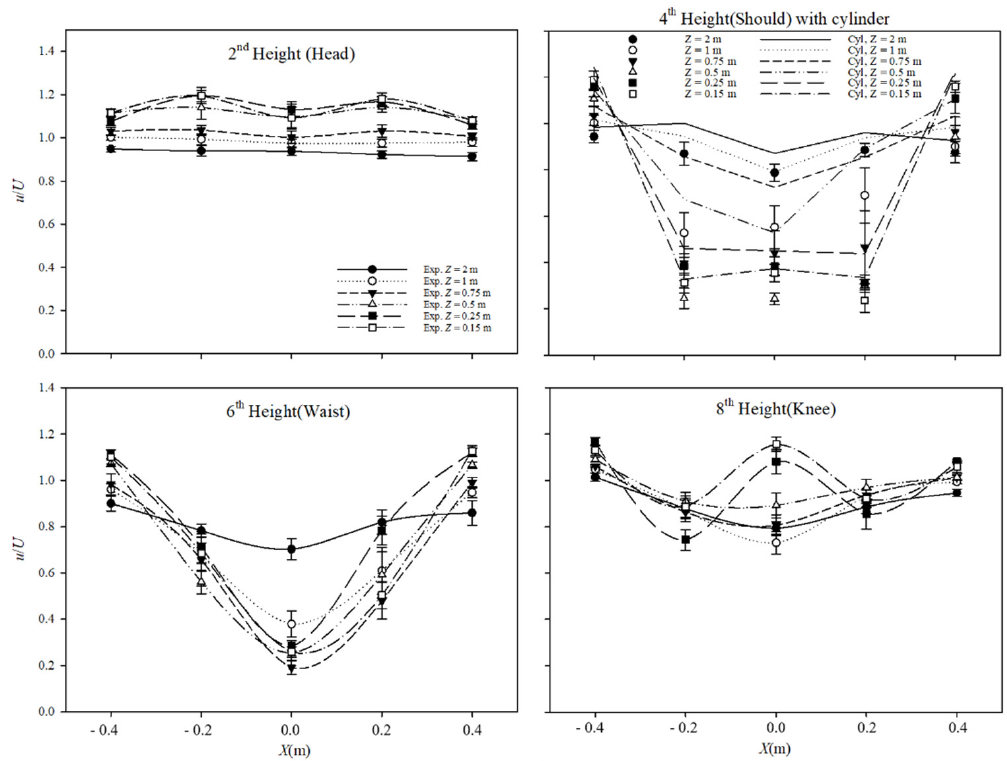
Figure 10. Results obtained for the cylinder and mannequin at the shoulder position (500 mm).